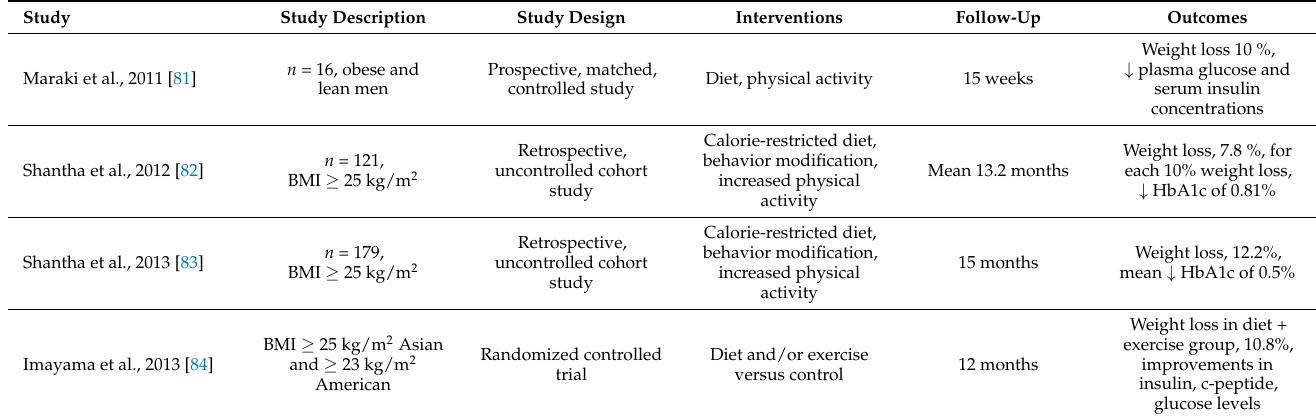
Table 3. Studies that have investigated the efficacy of combined lifestyle interventions to promote diabetes